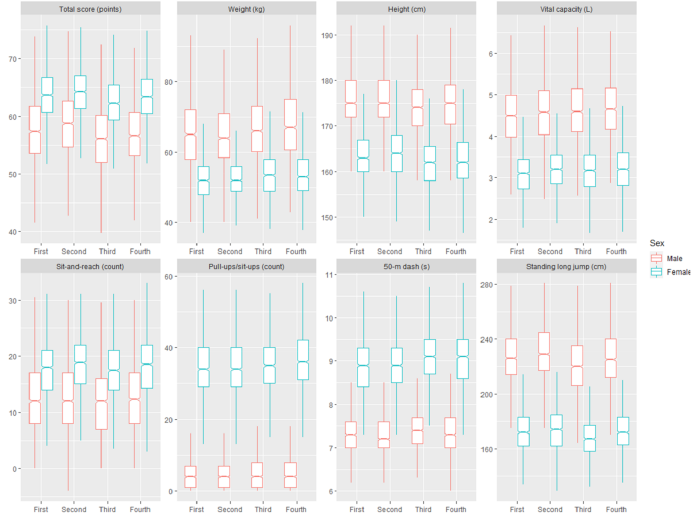
Figure 1. Boxplots of the total score and numerical measurements of seven single tests for four years in a row from 11,346 records for the 3202 subjects (red for male and blue for female). Middle line in box denotes the median. Notches in box represents a roughly 95% confidence interval for the median. Non-overlapping notches indicate significantly di ff erent at the 0.05 level. Outliers are not shown. Physical education was scheduled in the first and second years but absent in the third and fourth